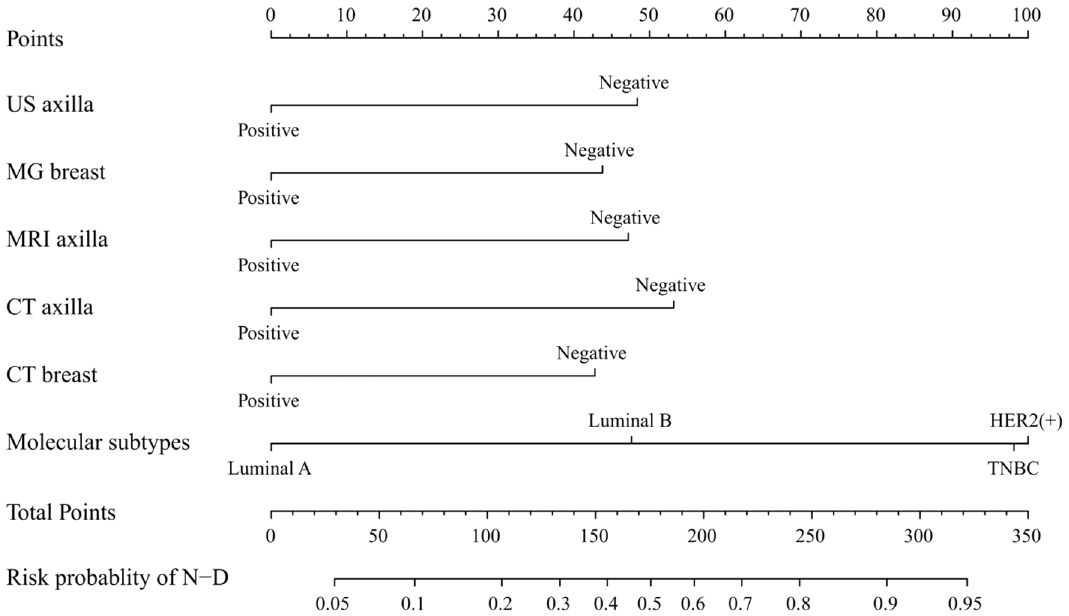
Figure 1. Nomogram to predict the individual probability of axillary nodal pCR after NAT. *Assessed on core biopsy before neoadjuvant